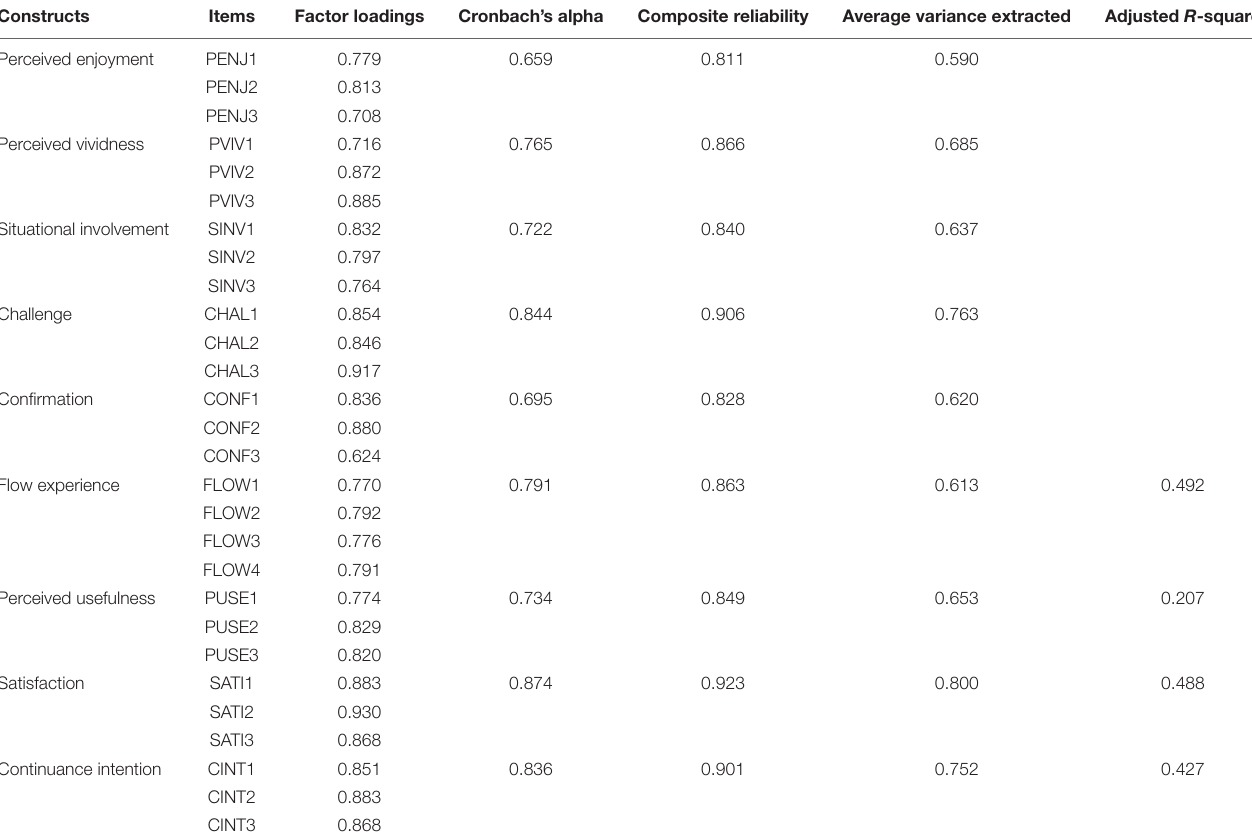
TABLE 1 | Convergent